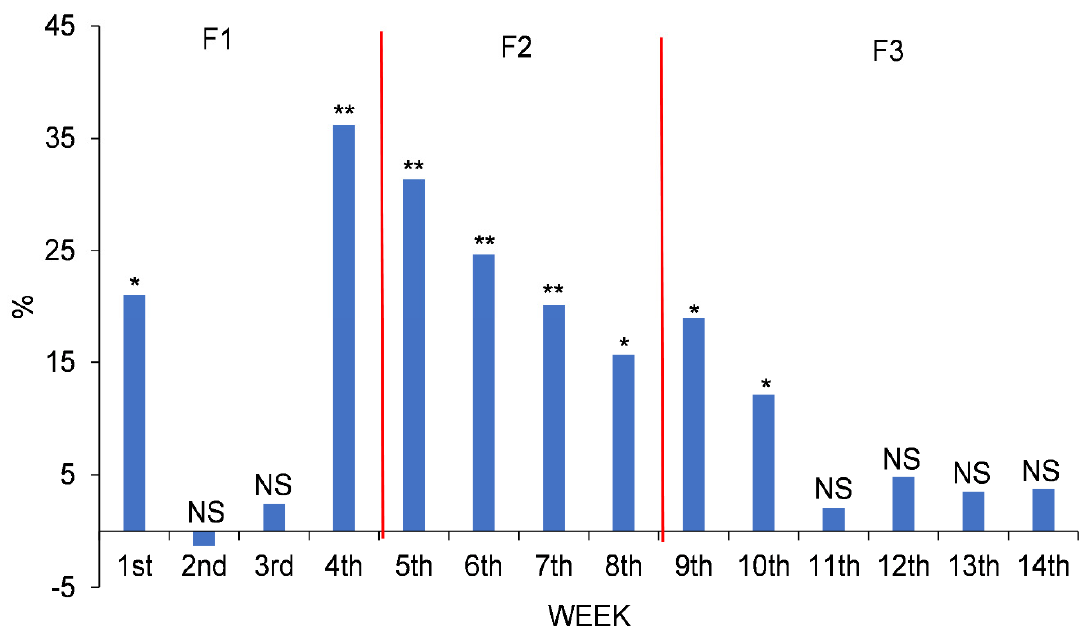
Figure 4. FI percentage increase in the C group over the TM group throughout the whole study period. NS, * or **: non-significant or significant at p < 0.05 or 0.01, respectively.